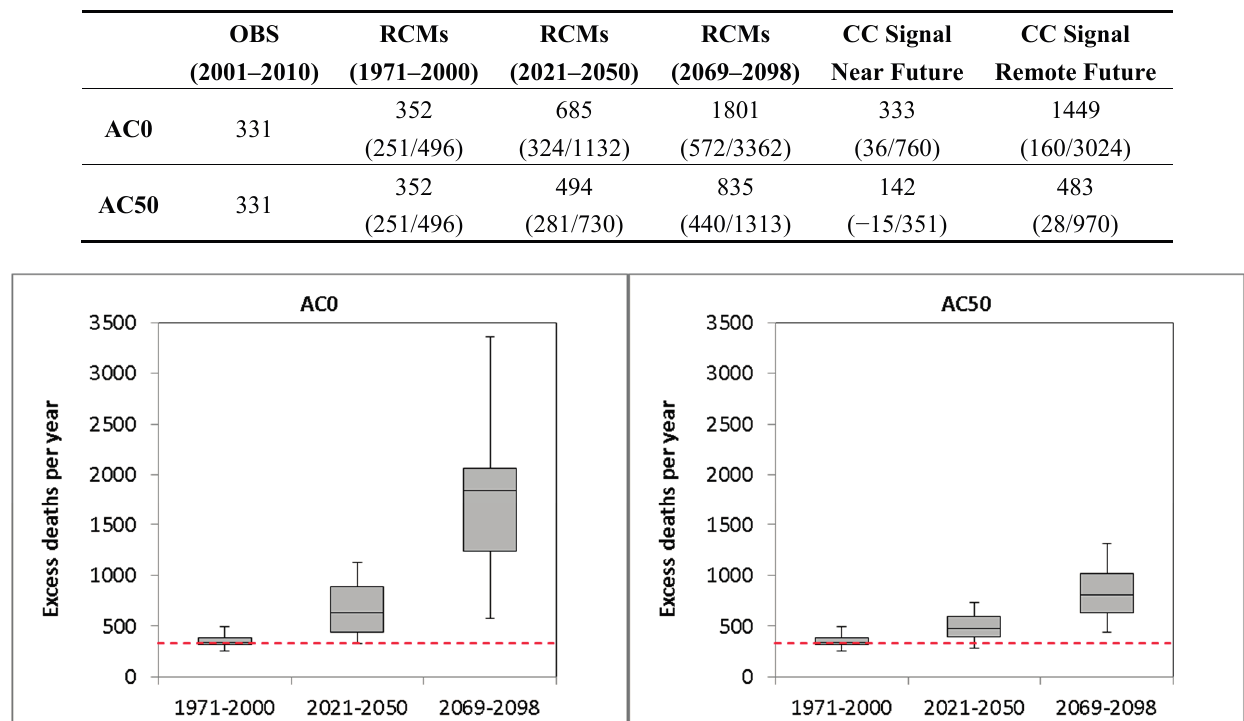
Table 3. Heat wave-related IHD excess deaths per year in Germany from observations (OBS, 2001–2010) and 19 regional model simulations for 1971–2000, 2021–2050, and 2069–2098 according to two acclimatization approaches: AC0 (upper row) and AC50 (lower row). The last two columns specify the climate change (CC) signals for near and remote future climate (2021–2050 and 2069–2098, respectively, compared to 1971–2000). Regarding the simulations, for each period the ensemble mean (first number) as well as the minimum and the maximum ensemble member (in parentheses) are listed.